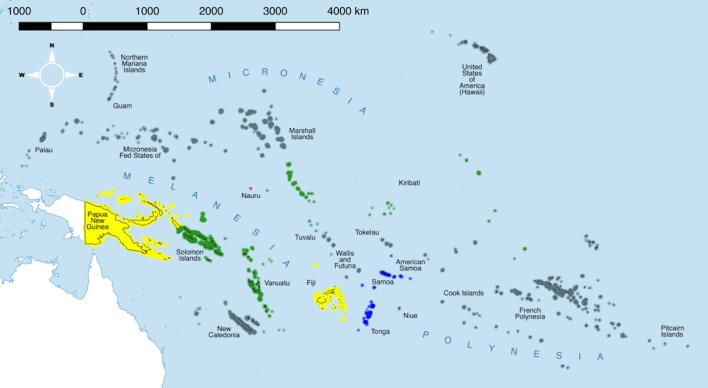
National-level summary of trachoma status following data extraction.Red: contemporary evidence of trachoma, current status unclear; yellow: some endemic districts, further mapping required, interventions not yet started; green: mapping complete, interventions implemented; blue: historic evidence of trachoma cases, no published contemporary data, current classification non-endemic; grey: no data or no reference to trachoma in available data or current classification non-endemic. Shapefiles downloaded from gadm.org and reproduced under a CC BY 4.0 license with permission from Dr Robert Hijmans. Map prepared in Miller projection using QGIS 2.16 [23].